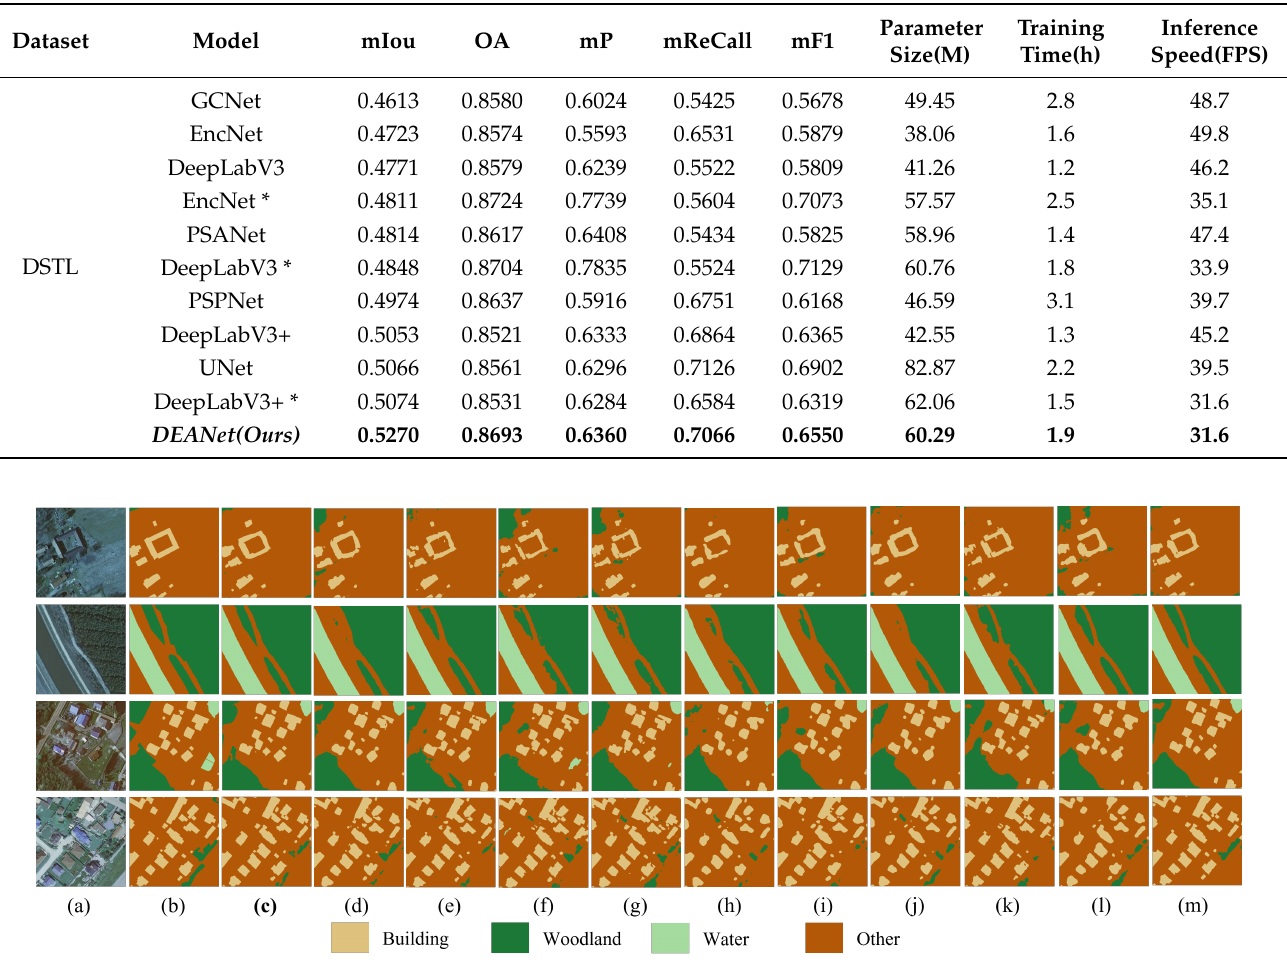
Figure 6. Comparison of different state-of-the-art models segmentation results on the LandCover.ai dataset: ( a ) Raw image, ( b ) Ground truth, ( c ) DEANet(Ours), ( d ) GCNet,( e ) PSPNet, ( f ) UNet, ( g ) DeepLabv3, ( h ) DeepLabV3+, ( i ) EncNet, ( j ) PSANet, ( k ) DeepLabV3+ *, ( l ) DeepLabV3 *, ( m ) EncNet *. (* represents using a 101-layer